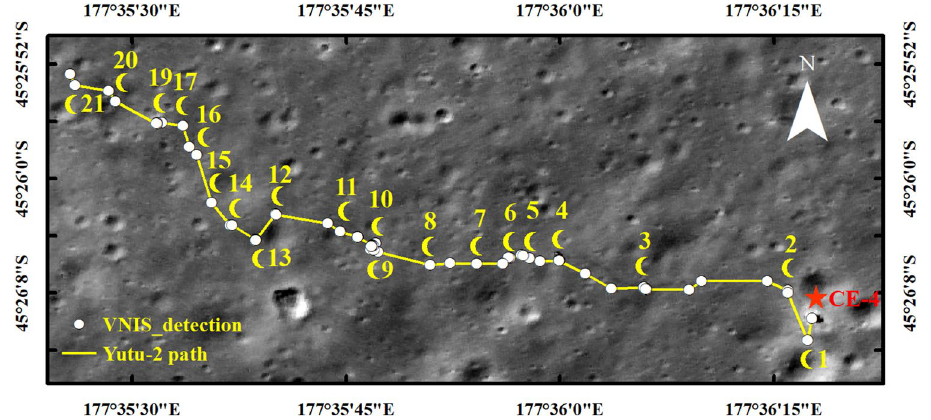
Figure 1. The routing path and the VNIS detections of the Yutu-2 rover during the 21 lunar days (except for the eighteenth lunar day when the Yutu-2 did not move). The number upper the point is the first VNIS detection of a new lunar day. The base map is from the LROC NAC image (image number M1311886645RC and M1311886645LC). This map was created in ESRI ArcMap 10.2 (https:// deskt op. arcgis. com/ zh- cn/